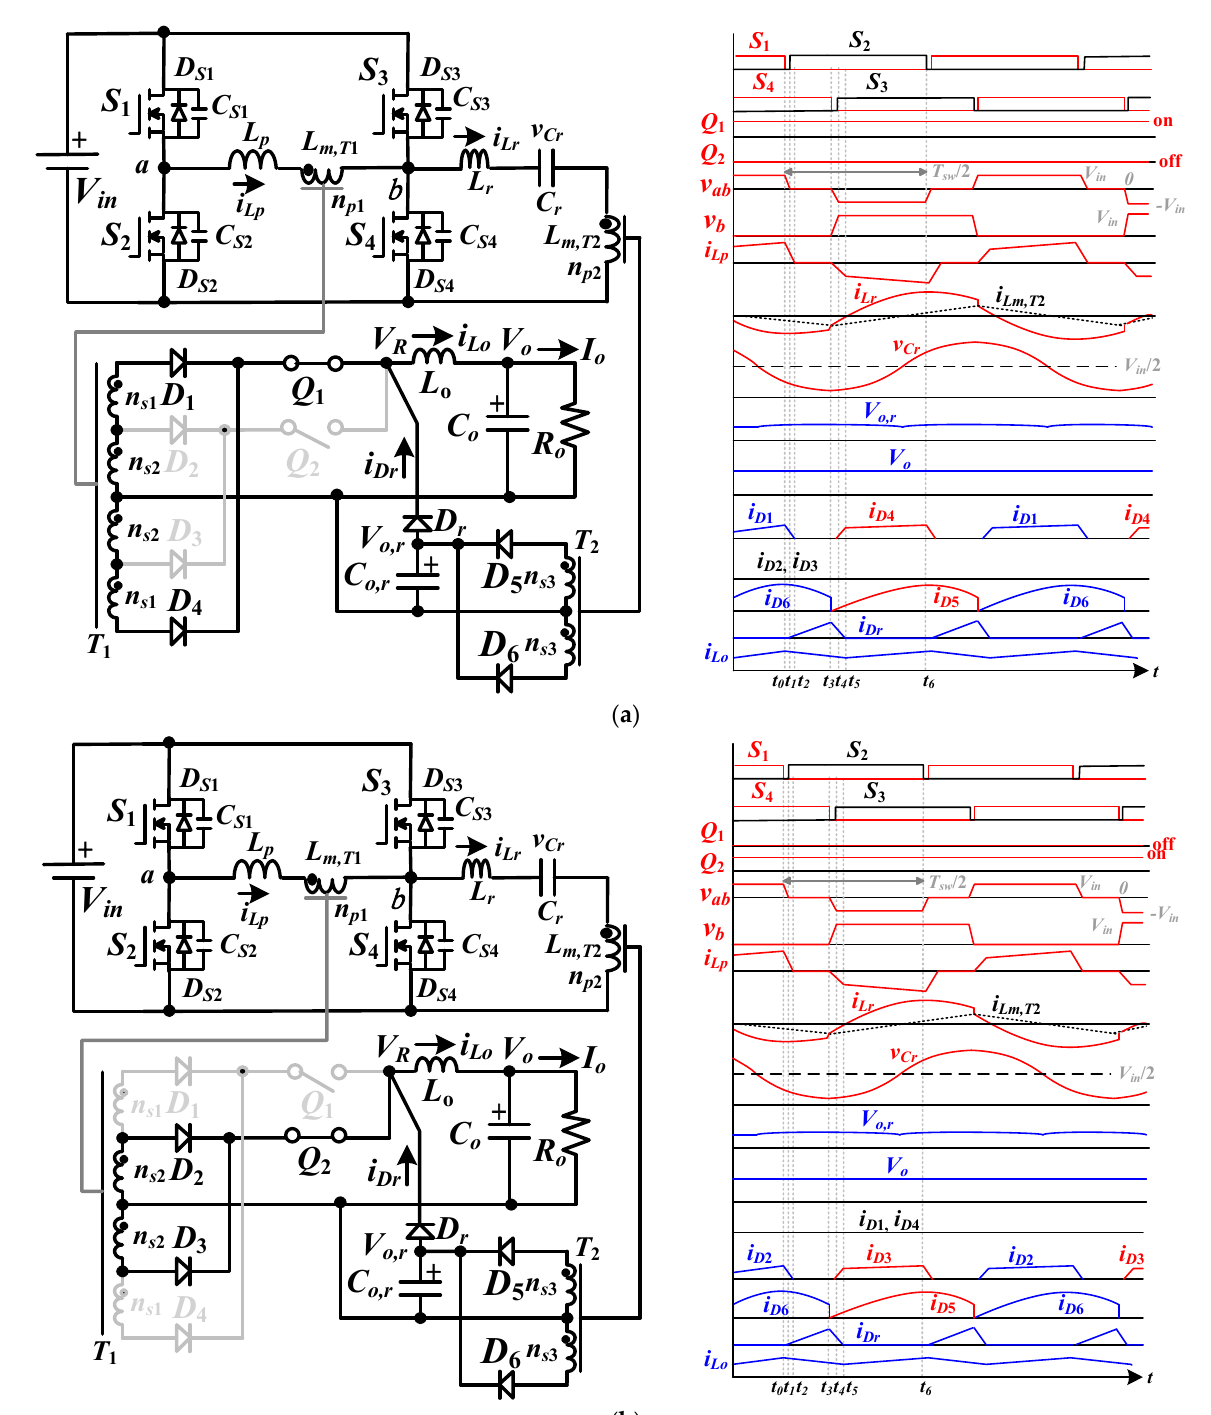
Figure 2. Equivalent sub-circuits and PWM signals under ( a ) low input voltage range ( b ) high input voltage range.